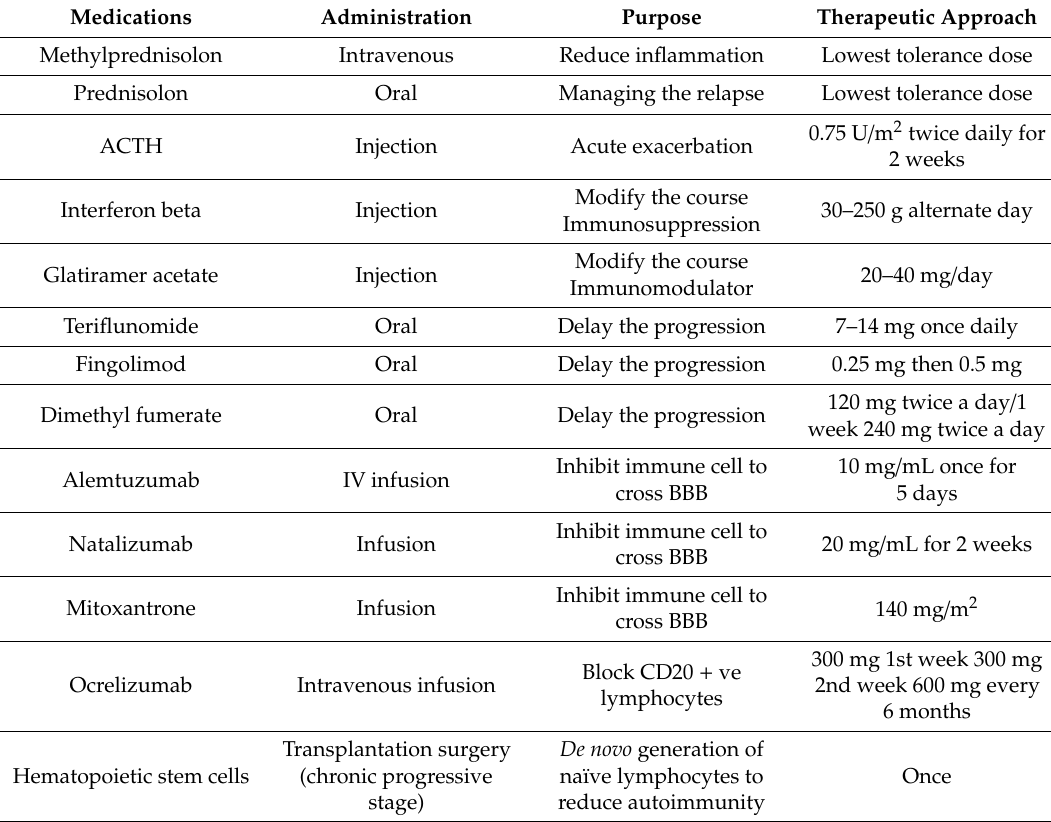
Table 1. A short list of common medications and other therapies for MS patients*. Medications Administration